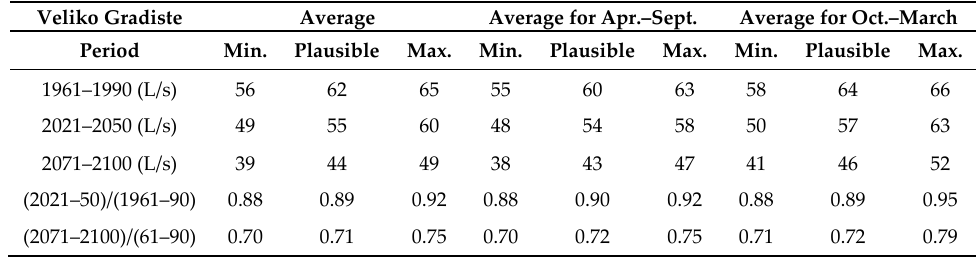
Table 2. Water Availability based on average annual hydrology at Jelak-VG. Veliko Gradiste Average Average for Apr.–Sept. Average for Oct.–March Period Min. Plausible Max. Min. Plausible Max. Min. Max.